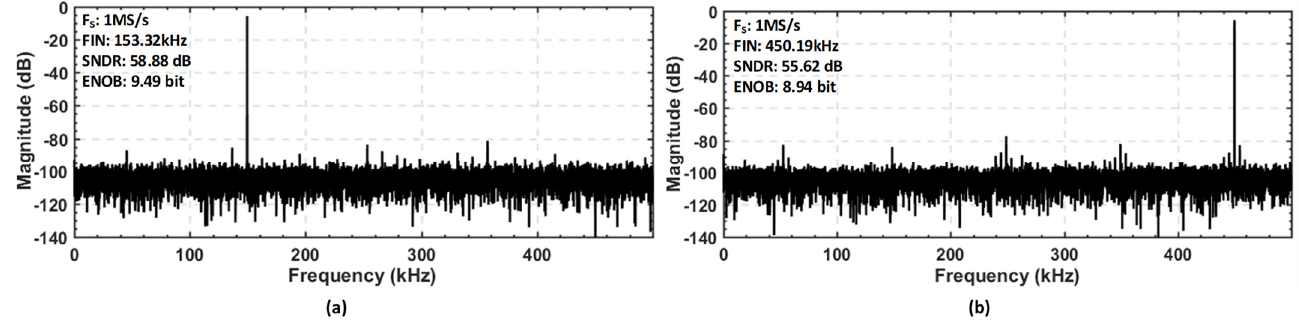
Figure 14. Measured dynamic performance at a sampling speed of 1 MS/s with the two different